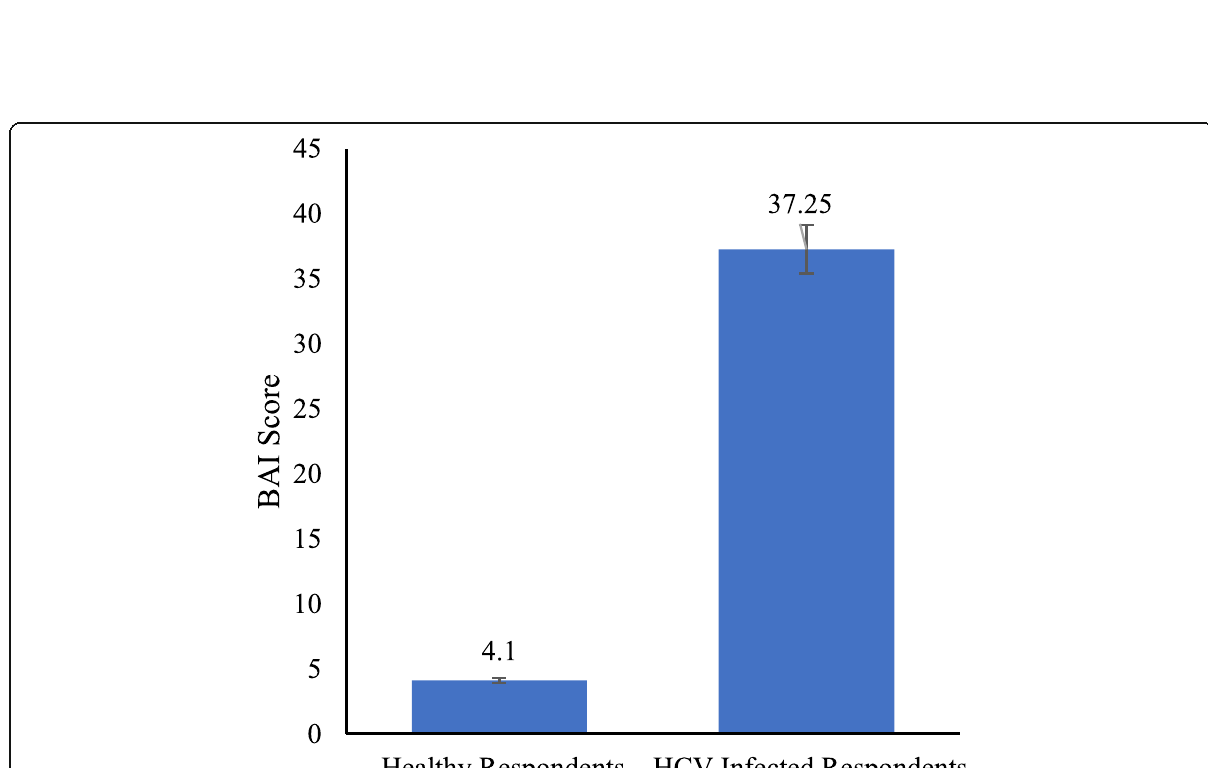
Fig. 2 BAI score of healthy vs HCV-positive